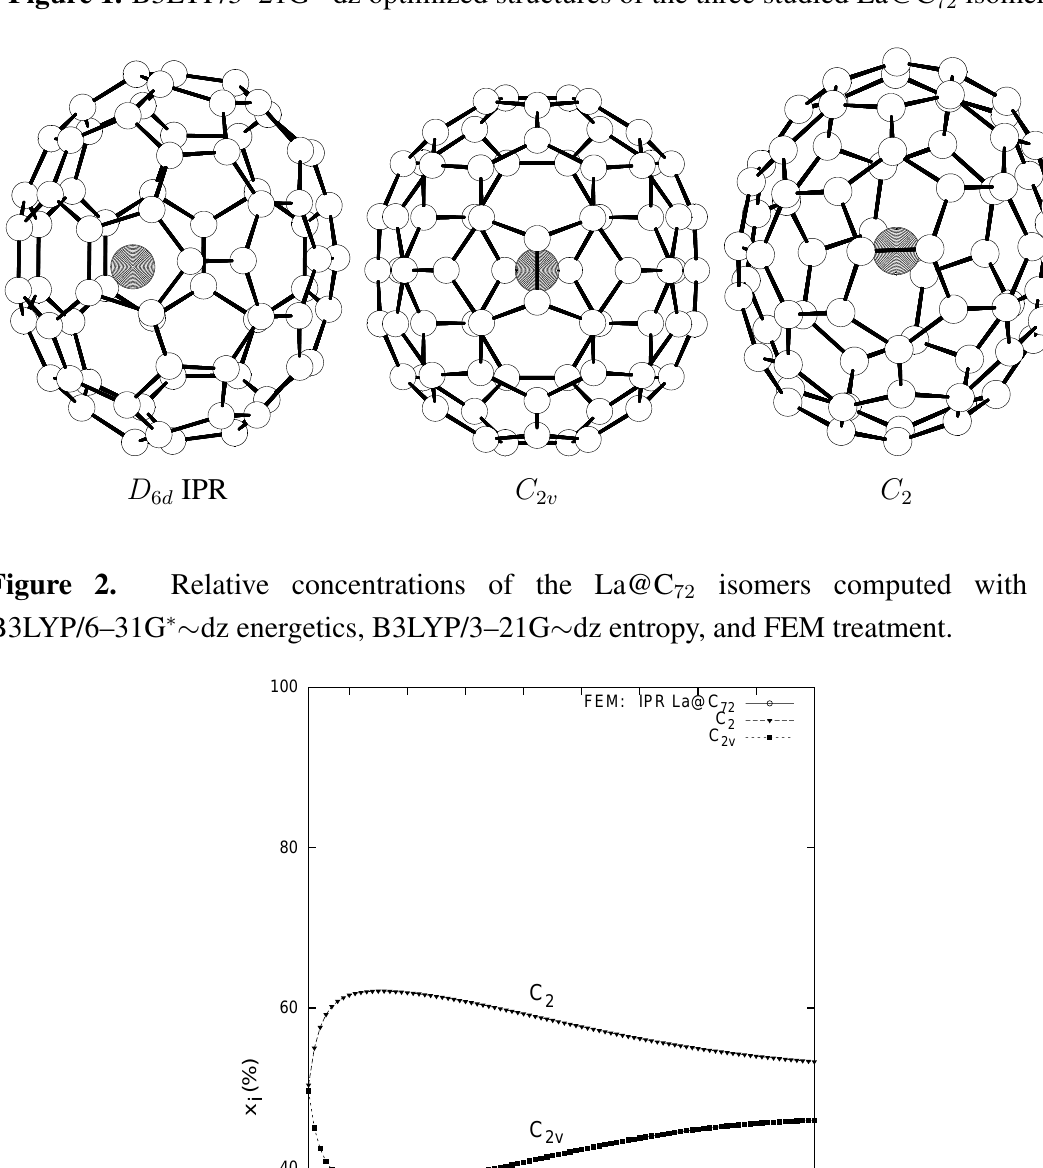
Figure 1. B3LYP/3–21G (cid:24) dz optimized structures of the three studied La@C